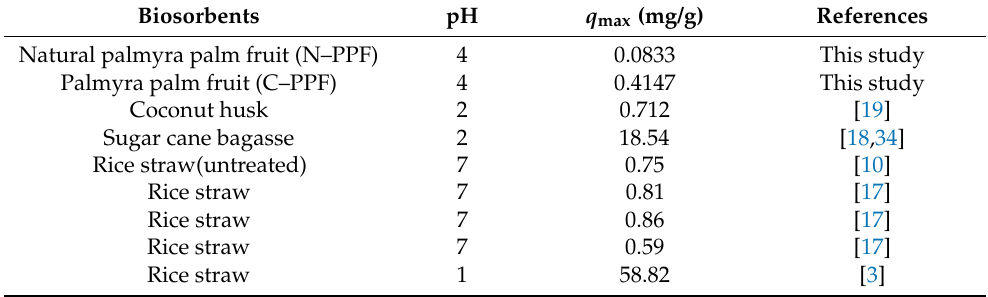
Table 6. Adsorption capacities of Fe(III) ions in aqueous solutions using different natural adsorbents. Biosorbents pH q max